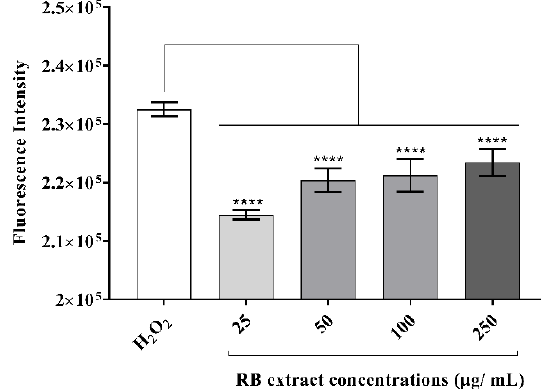
Figure 3. The effect of RB phenolic extracts on intracellular reactive oxygen species generation in oxidative stress-stimulated RAW264.7 cells. A significant reduction in intracellular reactive oxygen species generation, as indicated by the differences in the fluorescence intensity, is observed after treatment with the different concentrations (25 – 250 µg/mL) of RB phenolic extracts compared to the control (n = 8). The level of significance is indicated by the asterisks, whereby **** p < 0.0001. Data are presented as mean ± SD. Hydrogen peroxide, H 2 O 2 ; rice bran, RB.